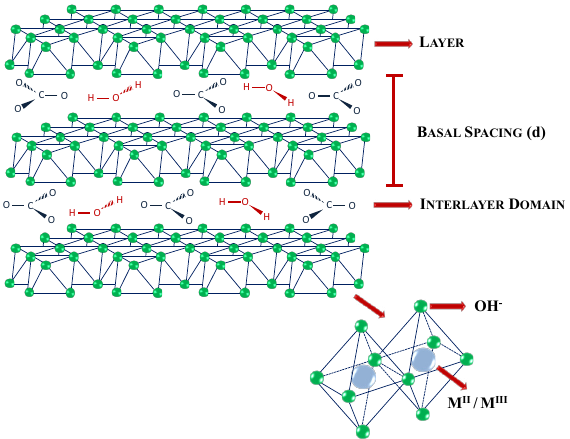
Figure 1. Layered Double Hydroxides (LDH) structure scheme.